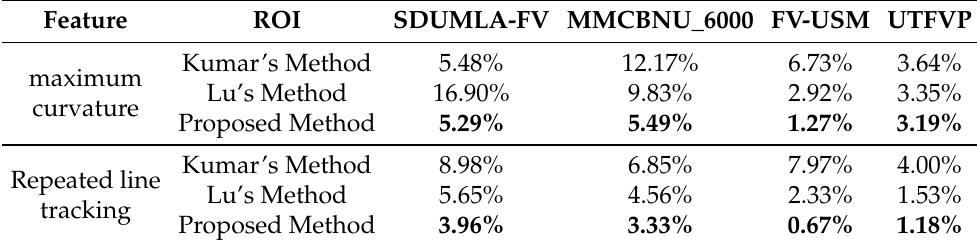
Table 3. EERs calculation on different datasets using maximum curvature and repeated line tracking feature extraction methods (The best matches are marked in